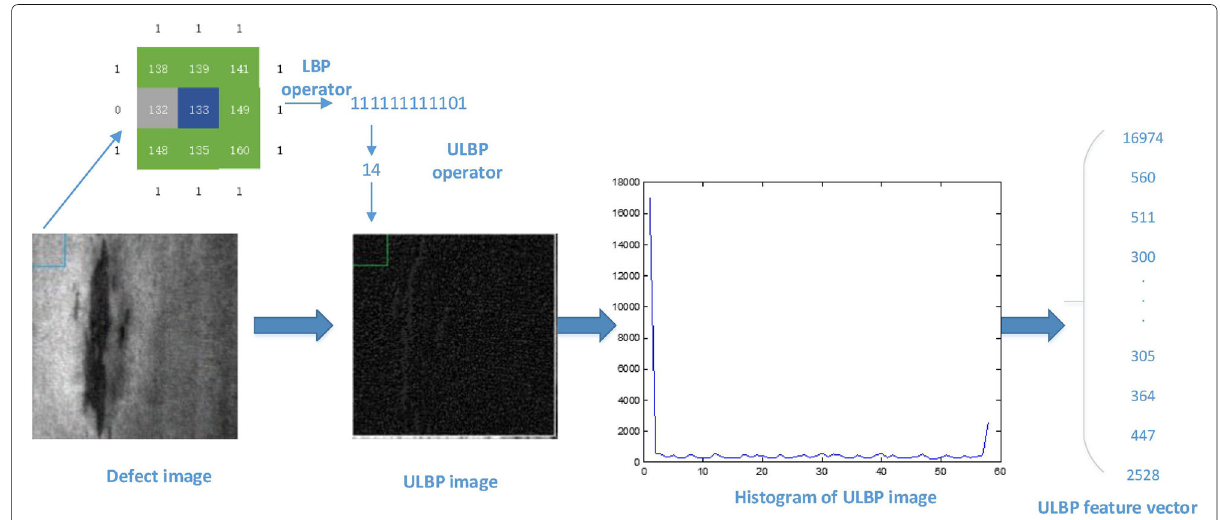
Fig. 4 Process to convert defect image to ULBP feature vector